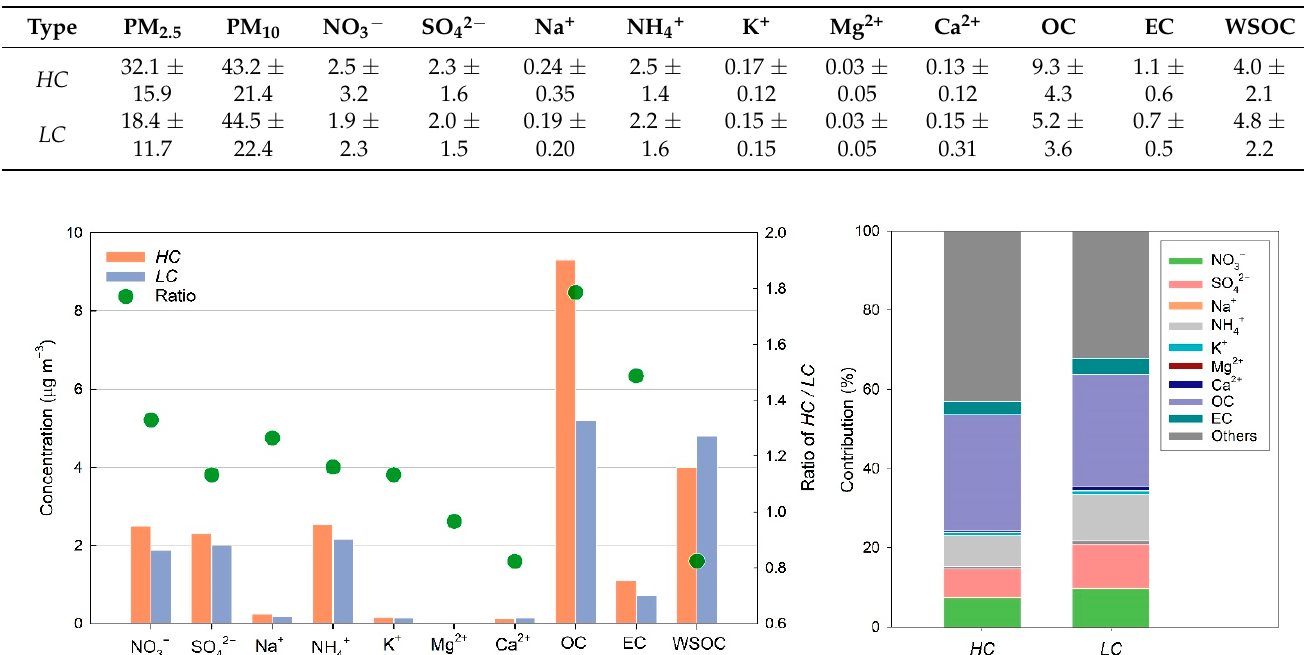
Figure 5. Concentrations of PM 2.5 components ( left ) and the fraction of each component in the PM 2.5 mass ( right ) for HC and LC samples. Green circles in the left plot indicate the concentration ratios of HC to LC samples for each PM 2.5 compo ‐ nent.